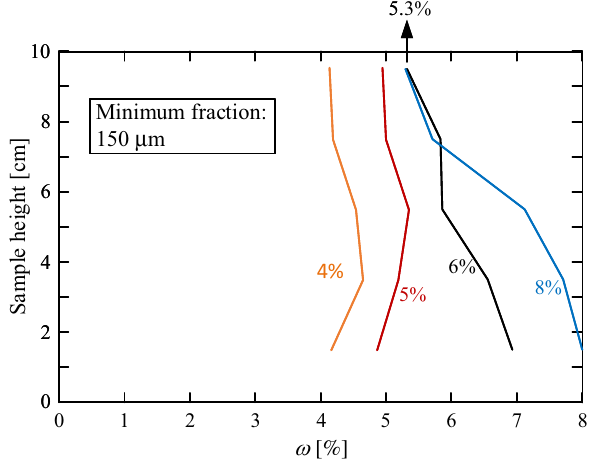
Figure 9. Vertical ω distributions of samples with different initial water contents.